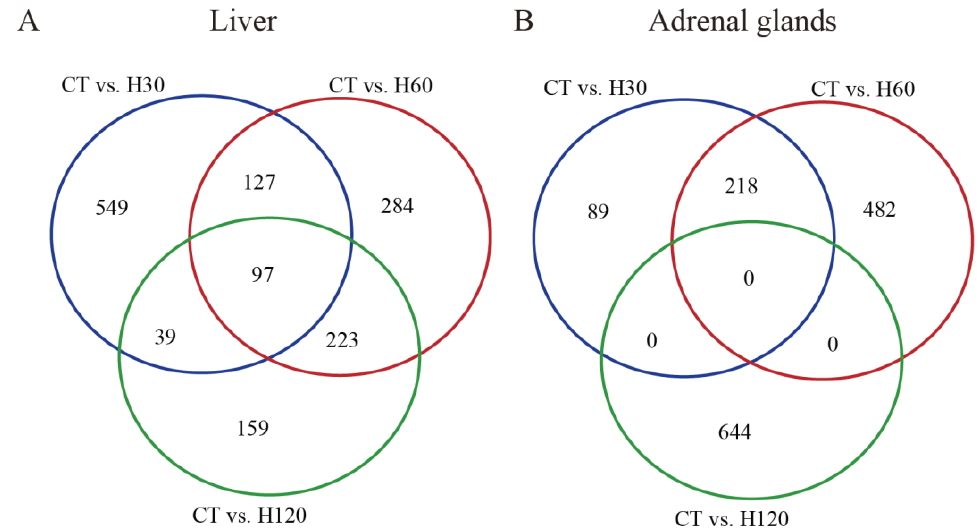
Figure 2. Venn diagrams of the known differentially expressed mRNA isoforms identified in all comparisons. ( A ) Venn diagram of the shared DEIs in the liver among three comparisons. ( B ) Venn diagram of the shared DEIs in adrenal glands among three comparisons. The blue, red, and green circles refer to the comparisons of CT vs. H30, CT vs. H60, and CT vs. H120, respectively.